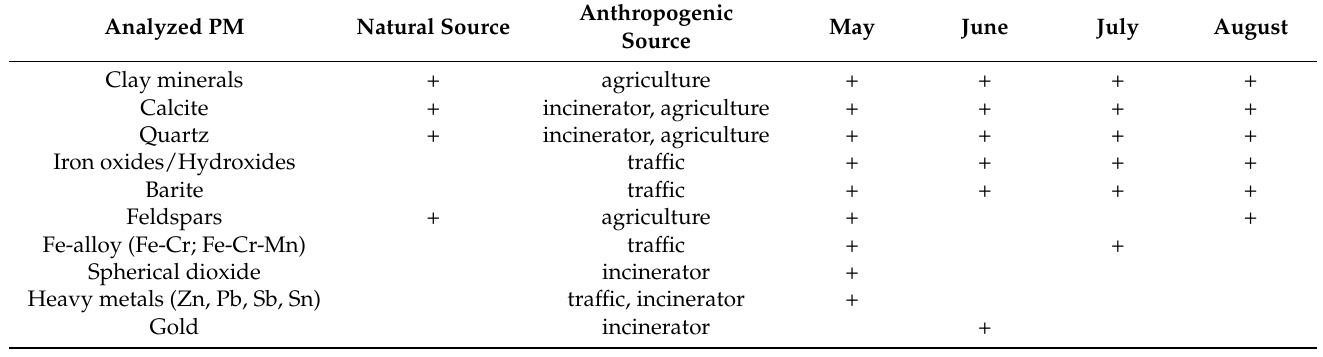
Table 1. Mineralogical phases and other PMs contaminating bee pollen collected in different months.